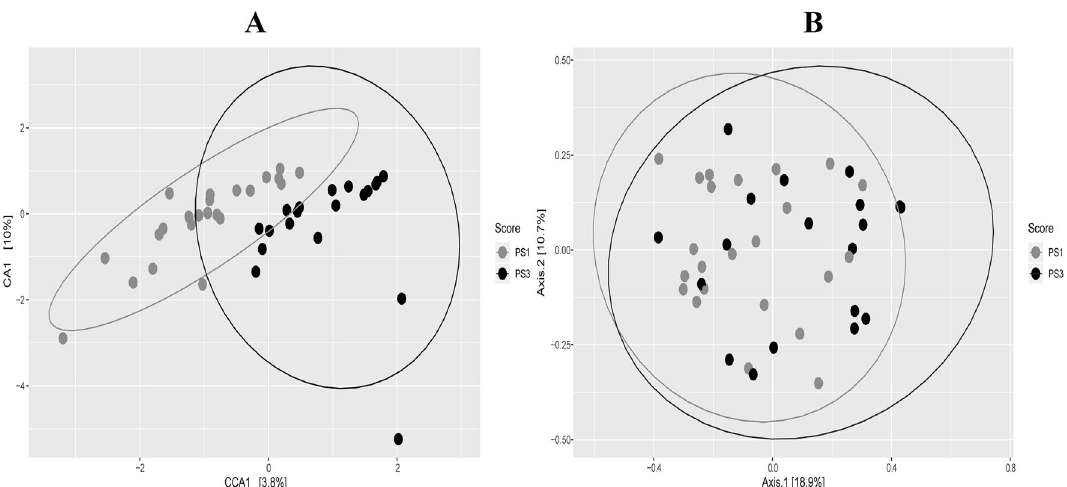
Figure 3. Vaginal swab community comparisons. ( A ) Canonical correspondence analysis showing maximum variation between samples in community due to perineal score (PS). Data for low risk animals (PS1) are depicted in light grey and high-risk animals (PS3) are in black. All points represent Bray Curtis dissimilarity measures for each sample. ( B ) Principal Coordinates Analysis showing differences in beta diversity of vaginal microbial communities from sows with different perineal scores (PS). All points represent Bray Curtis dissimilarity measures for each sample. Ellipses were based on a multivariate normal distribution of data points. There were statistical differences in overall microbial communities found using ANOSIM due to PS ( P <